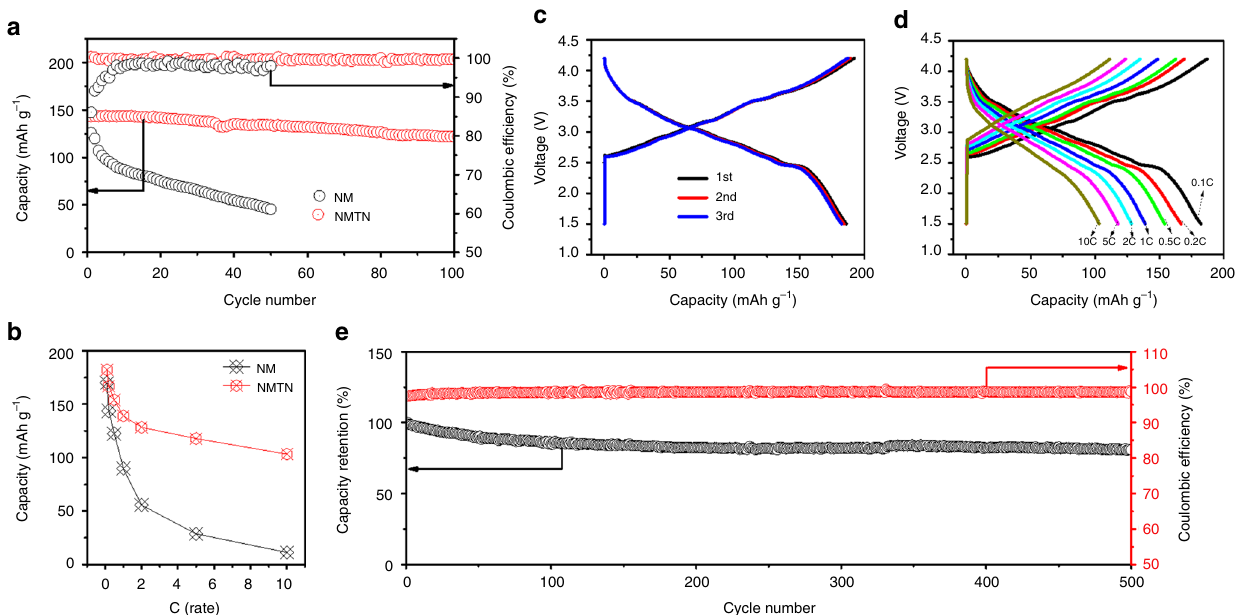
Fig. 5 Electrochemical performance of the as-prepared NM and NMTN cathodes. a Cycling performance of the NMTN electrode at 0.5-C rate, with that of the NM electrode for reference; b Rate capability of the NMTN electrode with that of NM electrode for reference; c Typical potential pro fi les of NMTN at 0.1-C rate; d Potential pro fi les of NMTN at different rates. e The cycling performance and Coulombic ef fi ciency of NMTN at 5-C